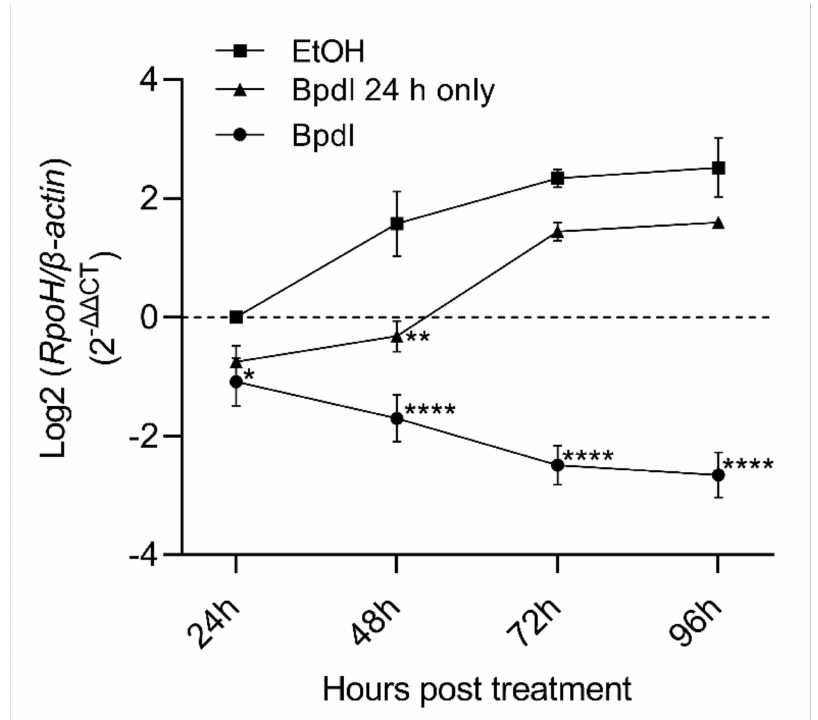
Figure 3. Anaplasma marginale levels in response to iron depletion and reversal of iron depletion. Anaplasma marginale levels in DAE100 cells maintained with the iron chelator Bpdl through time decreased as compared to the carrier control group (EtOH). Anaplasma marginale levels partially recovered following removal of the chelator after 24 h (Bpdl 24 h only). The y-axis is the log2 of the relative normalized expression of A. marginale rpoH relative to D. andersoni ß-actin . The average ± SEM of four independent replicates for Bpdl and three independent replicates for Bpdl 24 h only treatment is represented by the nodes and error bars. Asterisks indicate statistically significant differences between the Bpdl-treated, or recovered cells as compared to the carrier control at each time